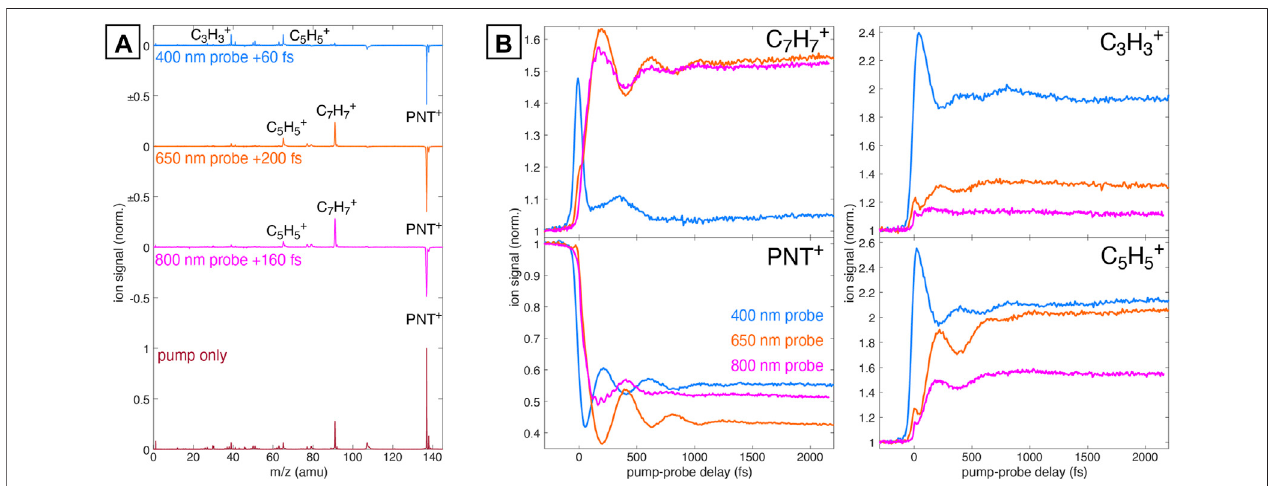
FIGURE 1 | (A) Mass spectrum of PNT + taken with 1,300 nm pump only (dark red) and the difference spectra relative to the pump-only spectrum taken with 800 nm(magenta),650 nm(orange),and400 nm(blue)probepulsesattheindicateddelays. (B) TransientionsignalsforPNT + ,C 7 H 7 + ,C 5 H 5 + ,andC 3 H 3 + takenateach probe wavelength. Each signal is normalized to its yield at negative pump-probe